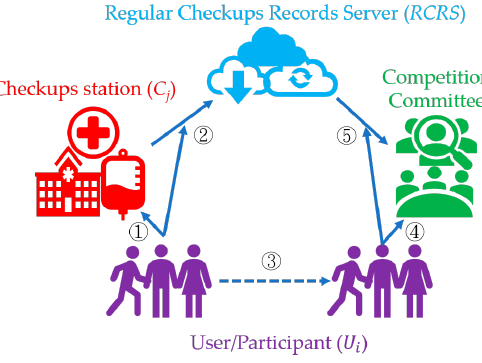
Figure 1. A scenario of our proposed two-phase pre-checkup and subsequent validation key agreement authentication mechanism (TCVK).